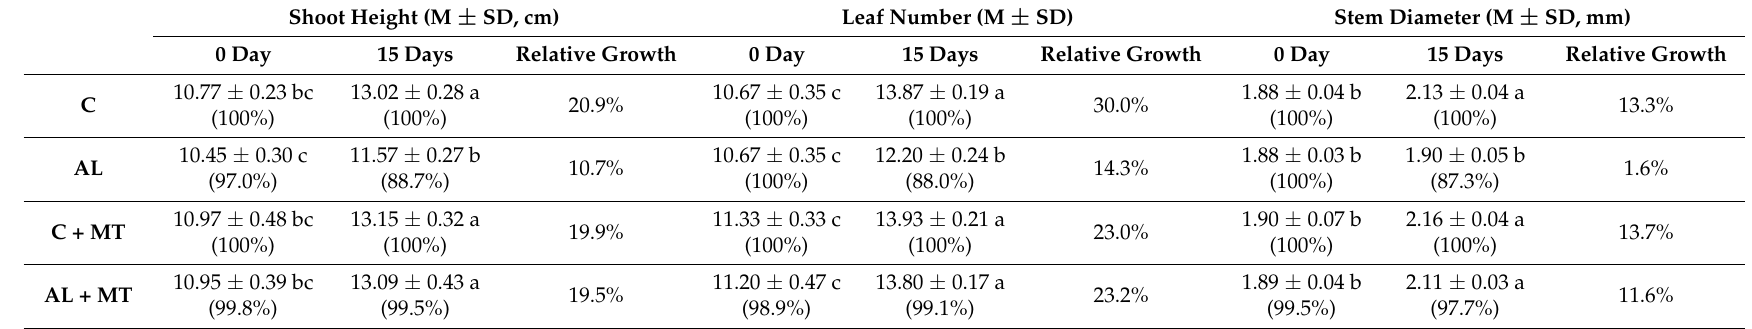
Table 1. Effects of 5 µ M melatonin treatment on growth of Malus hupehensis Rehd. seedlings under alkaline stress.